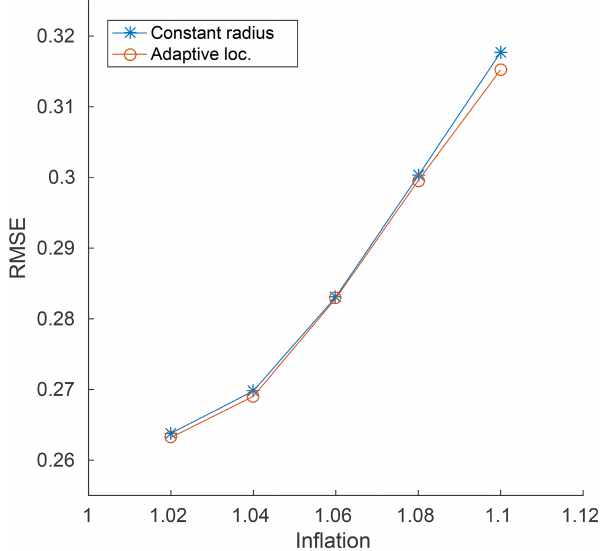
Figure 3. Lorenz’96 adaptive localization results. Comparison of the best univariate localization radius results with their correspond- ing adaptive localization counterparts. ¯ υ was varied by additive fac- tors of one of − 1, − 0 . 5, + 0, + 0 . 5, or + 1 with respect to the best univariate radius, with Var (υ) chosen to be one of 1 / 8, 1 / 4, 1 / 2, 1, or